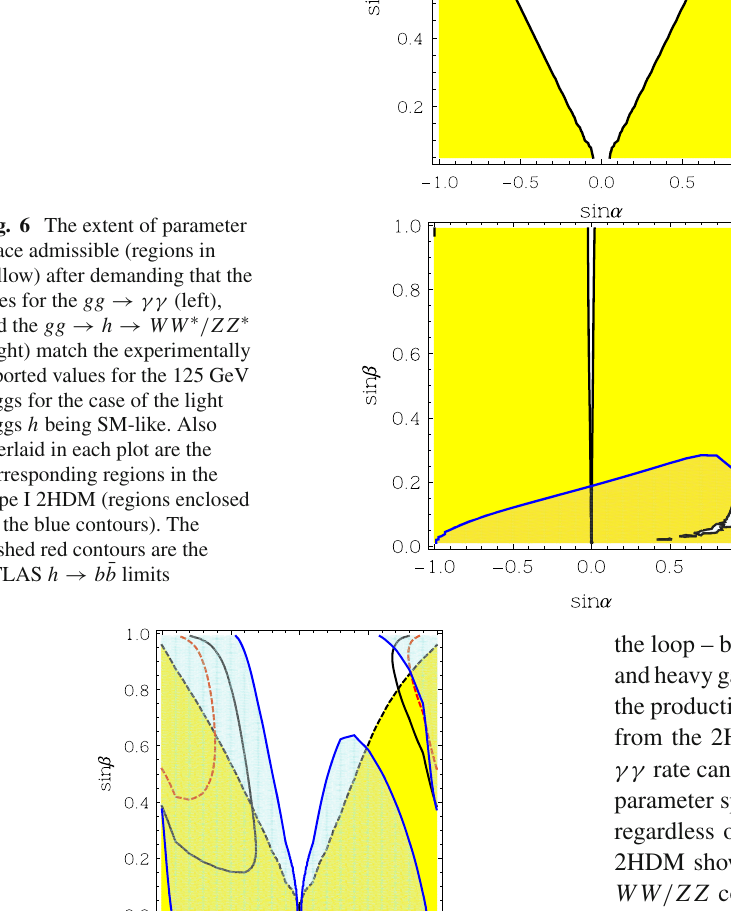
Fig. 5 The yellow shaded region corresponds to the 125 GeV lighter higgs h (left) and the 125 GeV heavier higgs H (right) yielding the reported value of gluon-fusion production cross-section